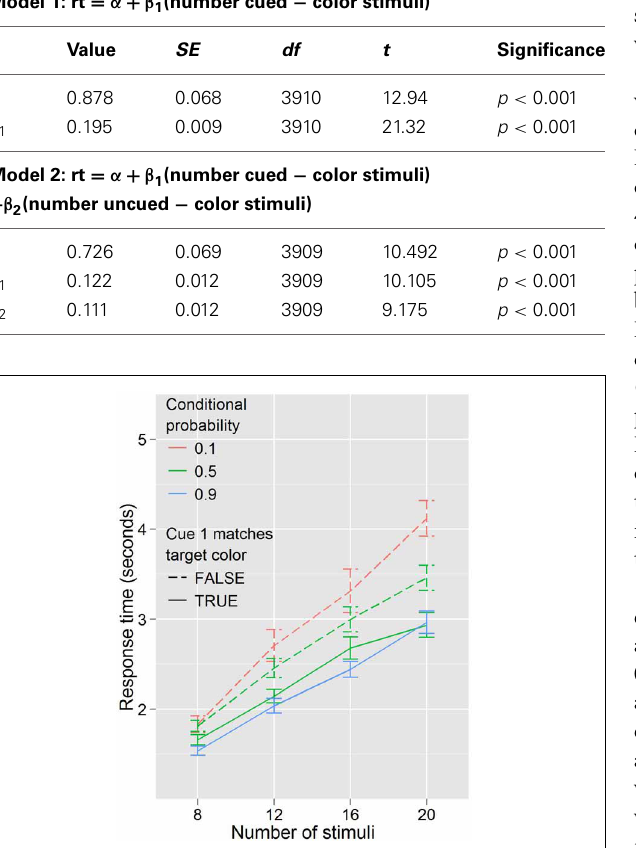
Table 2 | Intercepts and coefficients for the models generated by simple linear regression on the data from the 0.9 conditional probability condition in Experiment 3.